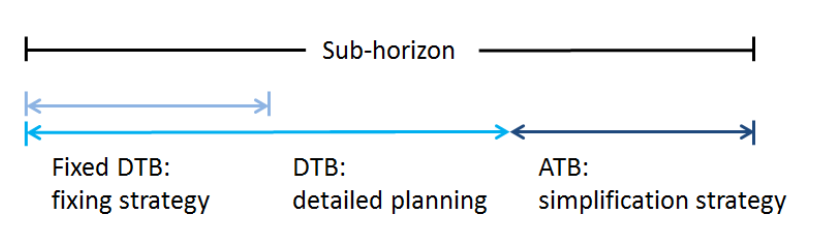
Figure 2. Illustration of the fixed detailed time block (DTB), the free DTB and the aggregate time block (ATB) of a general rolling horizon